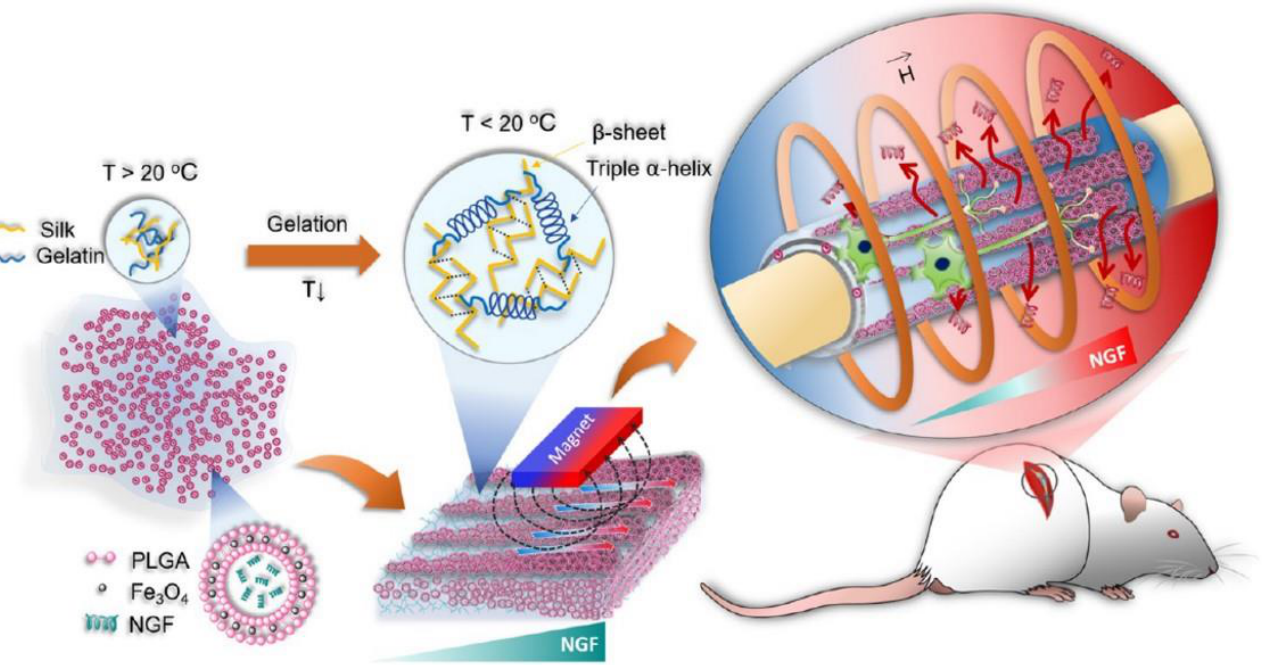
Figure 8. Schematic representation of the manufacturing process to produce an NGC with PLGA microparticles loaded with NGF and magnetic nanoparticles (Fe 3 O 4 ). The application of HFMF was able to trigger drug release over a chosen interval of time and indicated by the red arrows. Reproduced with permission from [91], Copyright © 2022 ACS Publications.